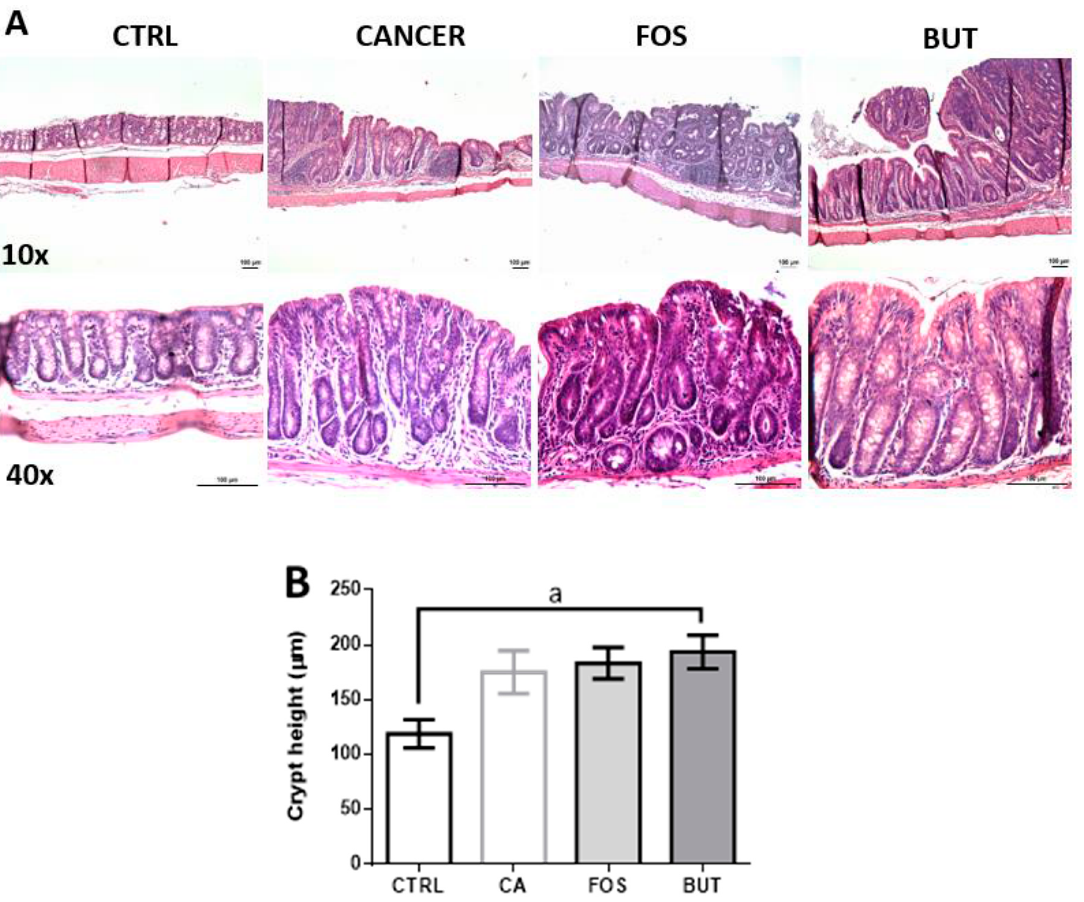
Figure 7. Butyrate promote hypertrophy of colonic crypts: Histological images of the colon ( A ) and colon crypt height ( B ). The tissues were subjected to haematoxylin and eosin (H&E) staining; the images represent 10 × and 40 × magnification; magnification bar: 100 µ m. Mice were divided into four groups: control group (CTRL— n = 5) fed with chow diet; and colon carcinogenesis-induced groups fed either with chow diet (CA— n = 5), TB-supplemented diet (BUT— n = 5), or with FOS-supplemented diet (FOS— n = 5). Colon carcinogenesis was induced chemically by azoxymethane (AOM)/dextran sodium sulphate (DSS). Data are presented as means ± SEM. The groups were compared using one-way ANOVA followed by Bonferroni post hoc tests; for p < 0.05 (a).